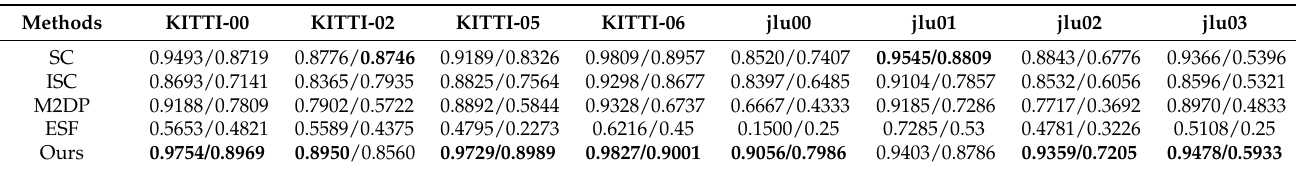
Table 1. F1 scores and EP scores over KITTI odometry sequences and JLU